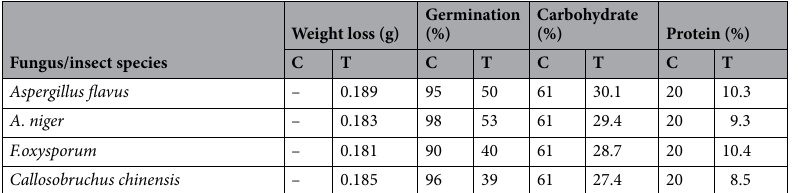
Oil concentration